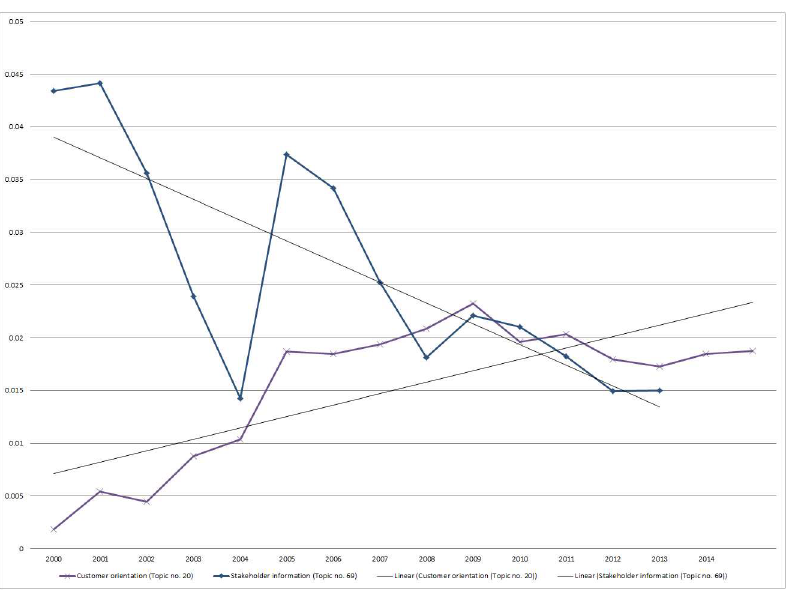
Fig 2. Trend analysis of mean probability of occurrence of topic no. 20 and no. 69 in the years2000 until 2014.